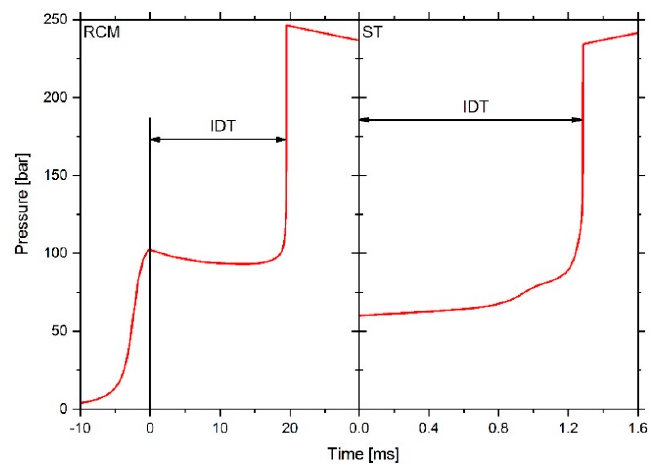
Figure 3. Simulated pressure history and ignition delay time (IDT) definition for rapid compression machine (RCM, left) and shock tube (ST, right) simulations.